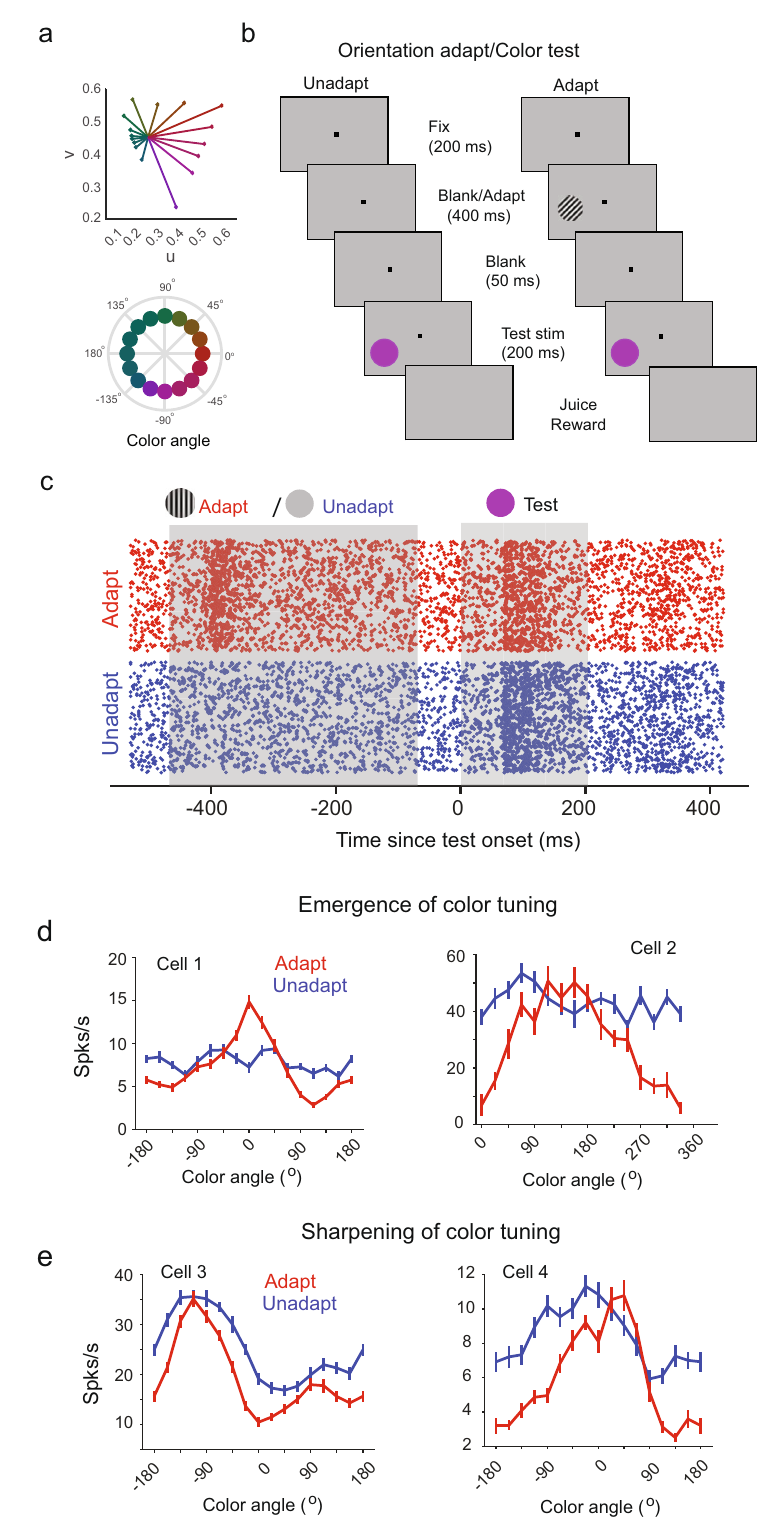
fi nd that 63.7% of the neurons were only tuned to color, 13.2% were only tuned to orientation, 8.8% were tuned to both color and orien- tation, and 13.2% were not signi fi cantly tuned to either color